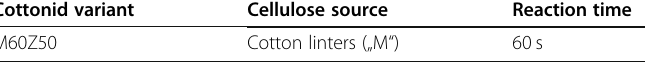
Table 1 Sample designation of structurally optimized Cottonid Cottonid